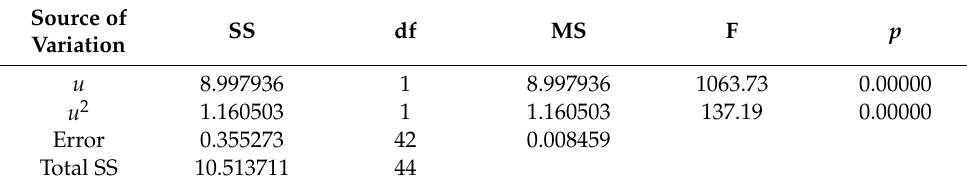
Table 5. Model of perpendicular shrinkage S P —ANOVA table, R 2 = 0.97; R adj 2 = 0.96. Source of Variation